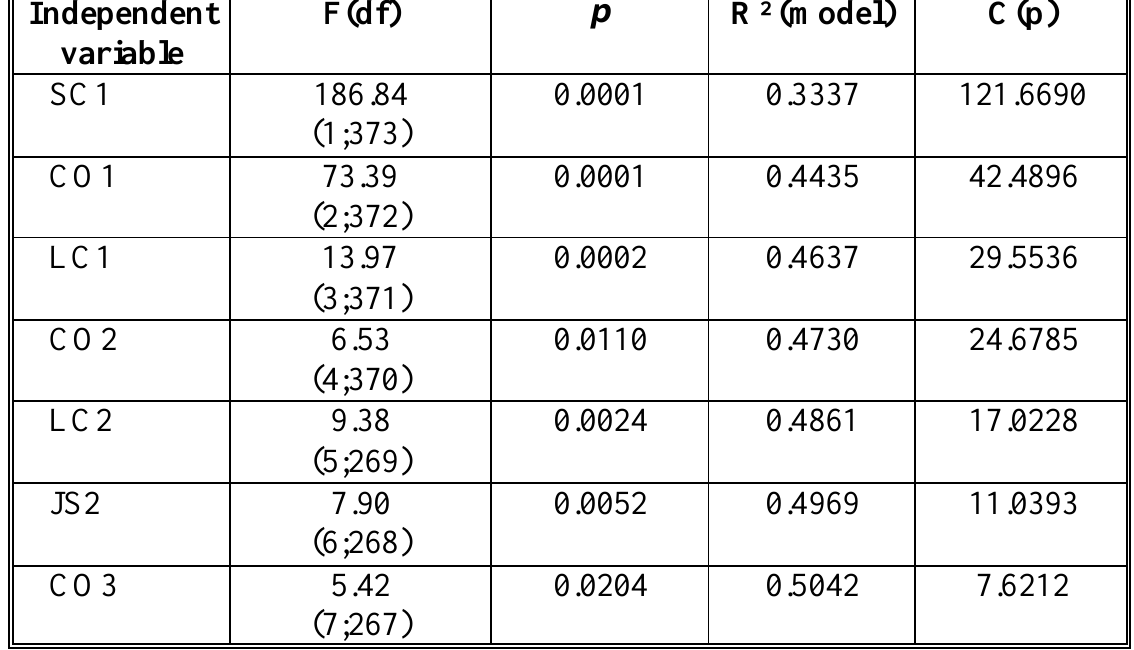
Dependent variable: Entrepreneurial attitude 1: Innovation (total sample N =